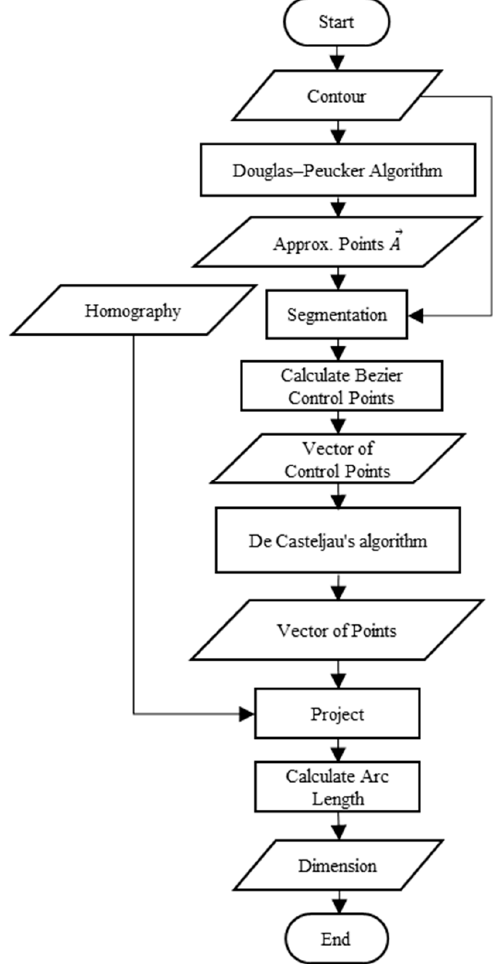
Figure 17. Flowchart of the contour converted the Bézier curve.